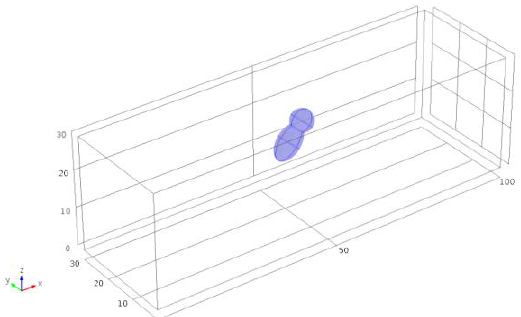
Figure 2. Design of the geometry used for the numerical simulation analysis.